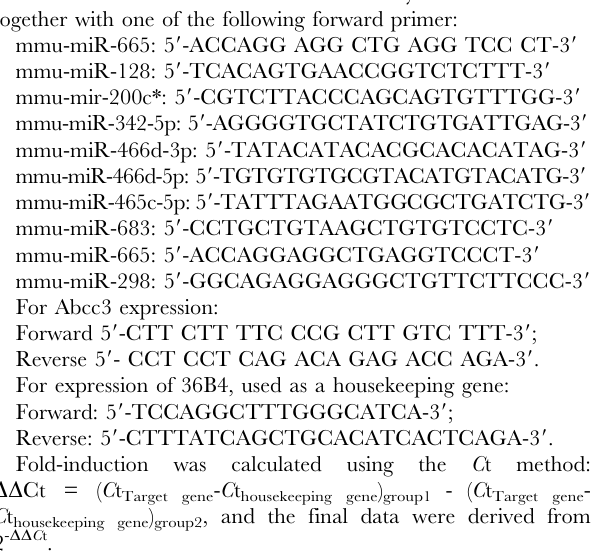
Table S6 DNA microarray-detected genes that were differen- tially expressed in the colon of colonized mice compared to germ- free